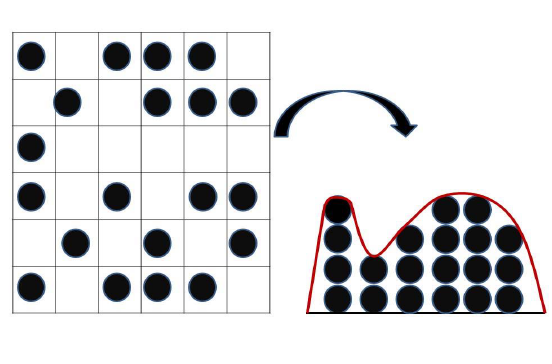
Fig. 1. 2-D to 1-D conversion through column